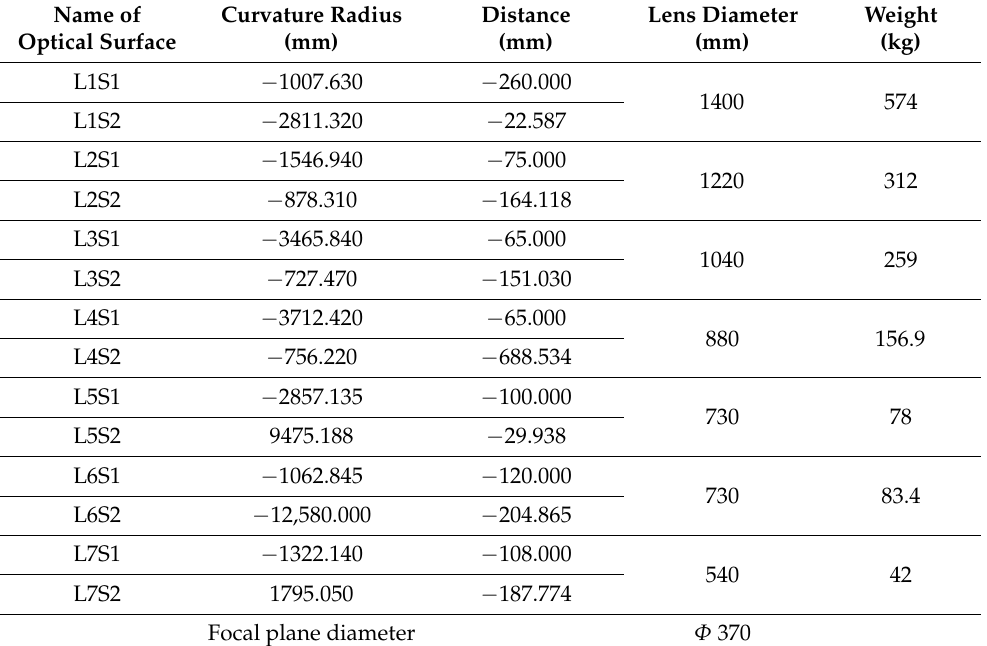
Table 4. Optical design parameters.